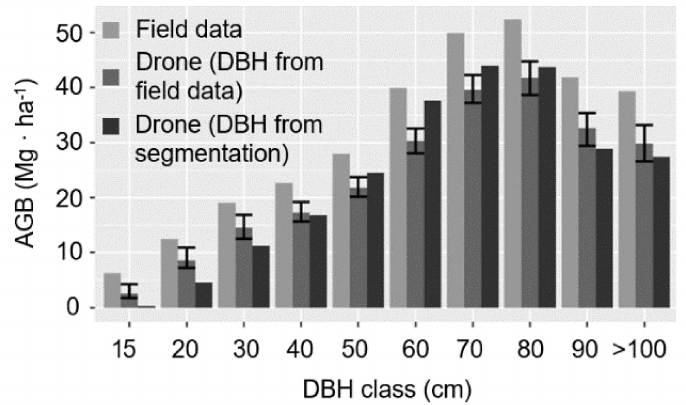
Figure 8. AGB in ten diameter size classes. For each size class, the three bars compare AGB from all trees mapped in the field (left) to the subset of trees segmented using drone lidar with AGB computed using field estimates of DBH (center), and the subset of trees segmented using drone lidar with AGB computed using DBH estimates from drone lidar segmentations (right). The di ff erence between the left and center bars is due exclusively to errors of omission. The di ff erence between the center and right bars is due exclusively to errors in DBH